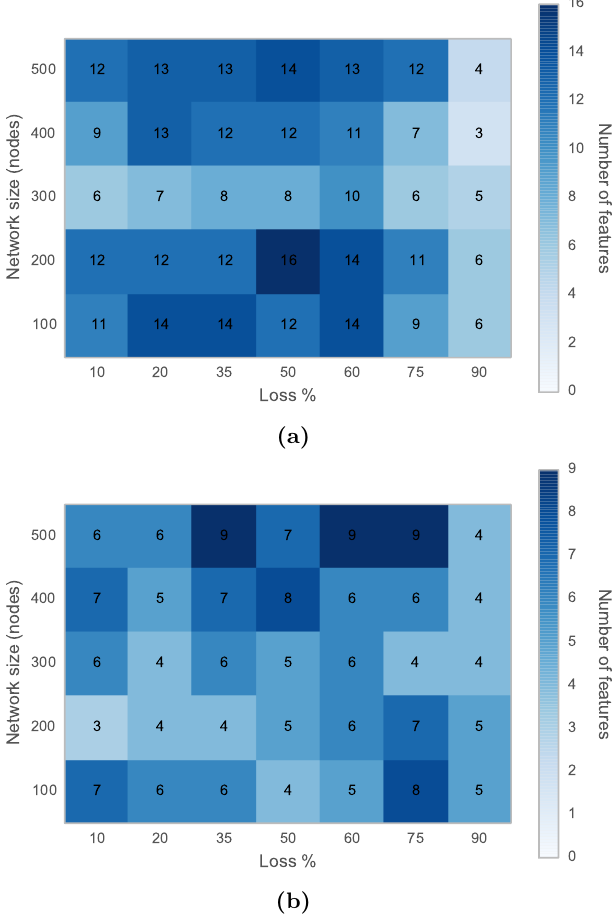
Figure 4: (a) Selected features (out of total 38) for every model at a given network size and loss model as described in Section 3.2. (b) Selected features (out of 23) feed-forward loop connected motifs. Cri- teria: select features that have higher than average feature importance using random forest regression.